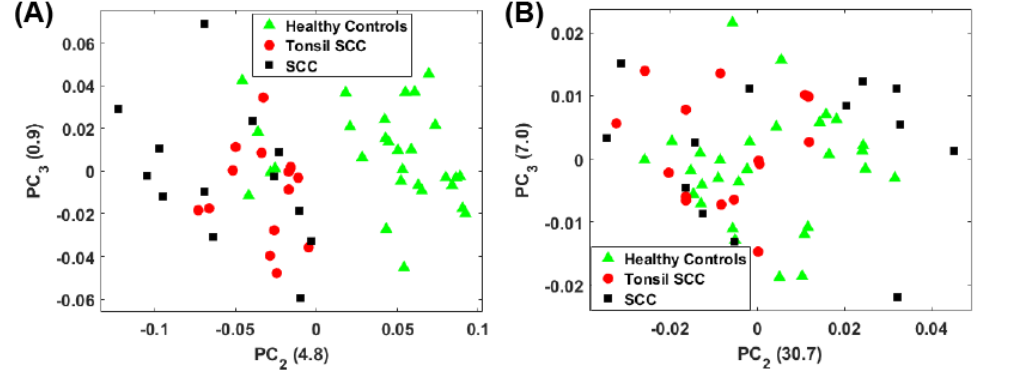
Figure 5. Plot of the second and third principal component scores for ( A ) for the full spectrum (100 cm − 1 –4300 cm − 1 ) and ( B ) the conventional fingerprint (400 cm − 1 –1800 cm − 1 ). The full spectrum analysis reveals a distinct boundary between the healthy and diseased tissue, however no obvious separation of the data is observed when looking at the conventional fingerprint region. This increased separation is due to the peaks observed outside the conventional fingerprint regime. The numbers in parentheses represent the information content associated with each principal